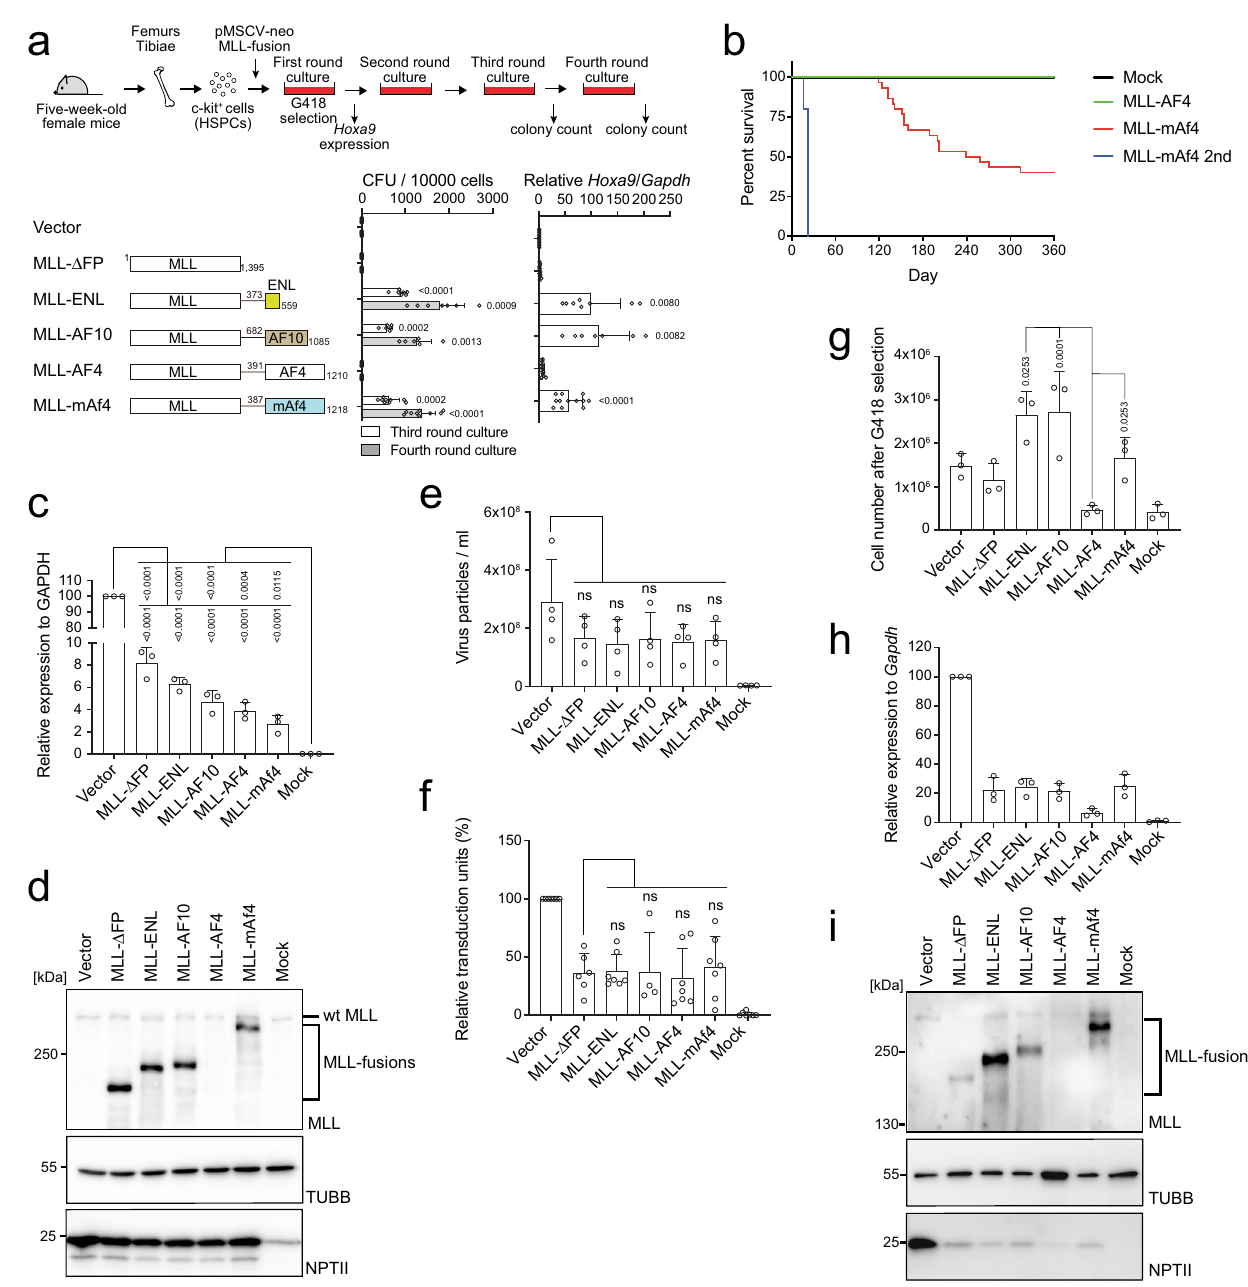
Fig. 1 | MLL-AF4 translation is inhibited by post-transcriptional regulation. a Colony-formingunits(CFUs)ofvariousMLLfusionsper10,000cellsatthird-and fourth-round passages under myeloid conditions ( n =9: Vector, MLL- Δ FP, MLL- AF4,MLL-mAf4; n =7:MLL-ENL; n =6: MLL-AF10). Hoxa9 expression normalized to that of Gapdh of fi rst round colonies is shown as the relative value of the vector control (set to 1) ( n =12, Vector, MLL- Δ FP, MLL-AF4, MLL-mAf4; n =8: MLL-ENL; n =7: MLL-AF10). b Leukemogenic potential of MLL-AF4 and MLL-mAf4 in vivo. Murine HSPCs were transduced with MLL-AF4 constructs and transplanted into syngeneic mice (mock, n =6; MLL-AF4, n =10; MLL-mAf4, n =30; MLL-mAf4 sec- ondary transplantation n =5). c mRNA expression of the MLL fusion genes in 293T cells analyzed using a qPCR probe for the EPS region in the pMSCV neo plasmids ( n =3). d Western blotting of MLL fusions in 293T cells transfected with the MLL fusion expression vectors in c . Anti-beta tubulin (TUBB) (an internal standard) and neomycin phosphatase II (NPTII) antibodies (a gene transduction control) were included for comparison. e Virus particle production by the MLL